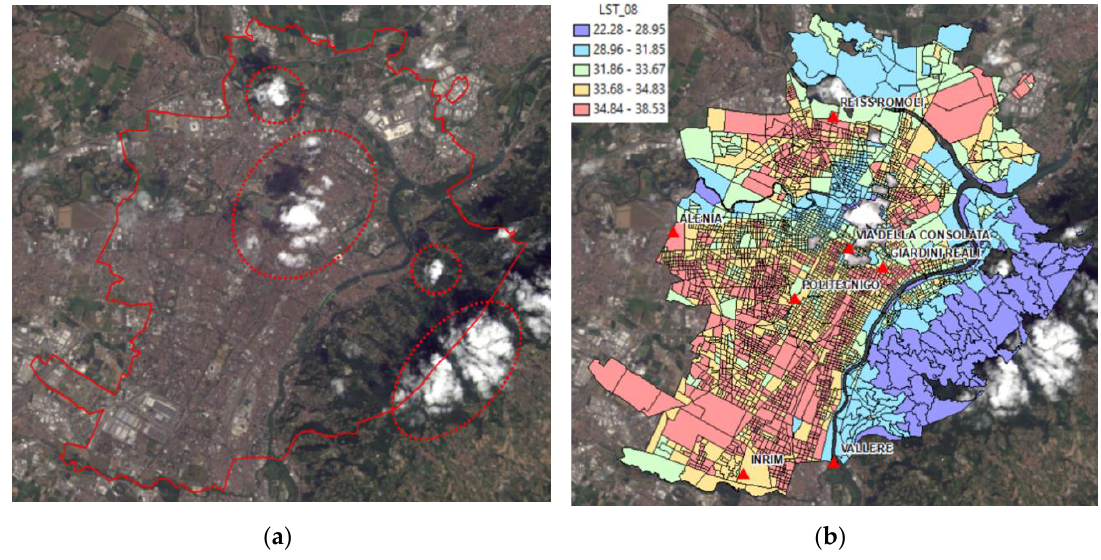
Figure 8. Landsat 8 satellite images: ( a ) referring to 25 August 2016 at 10.11 am; ( b ) LST in °C at a building block scale (the red triangles represent the weather stations).